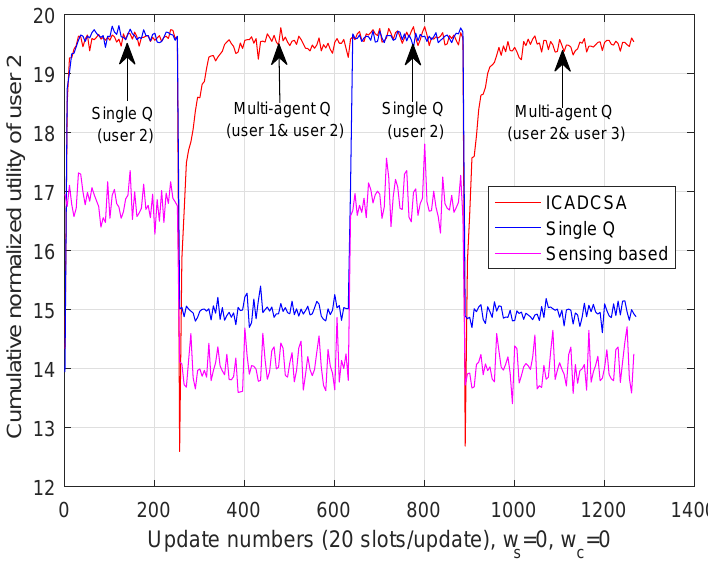
Figure 9. Cumulative normalized utility of User